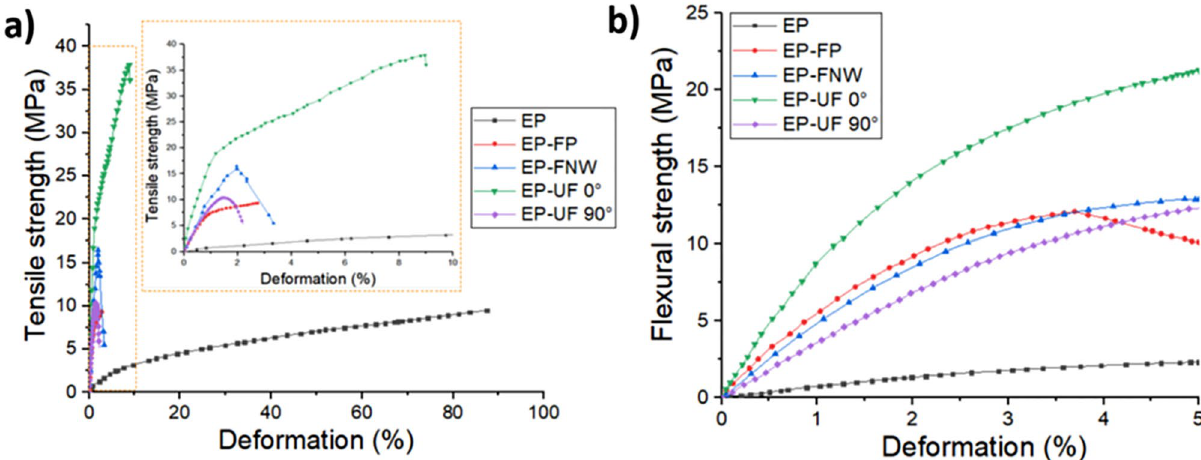
Figure 5. Average Tensile and flexural stress vs deformation of neat EP and their EP-fique biocomposites.